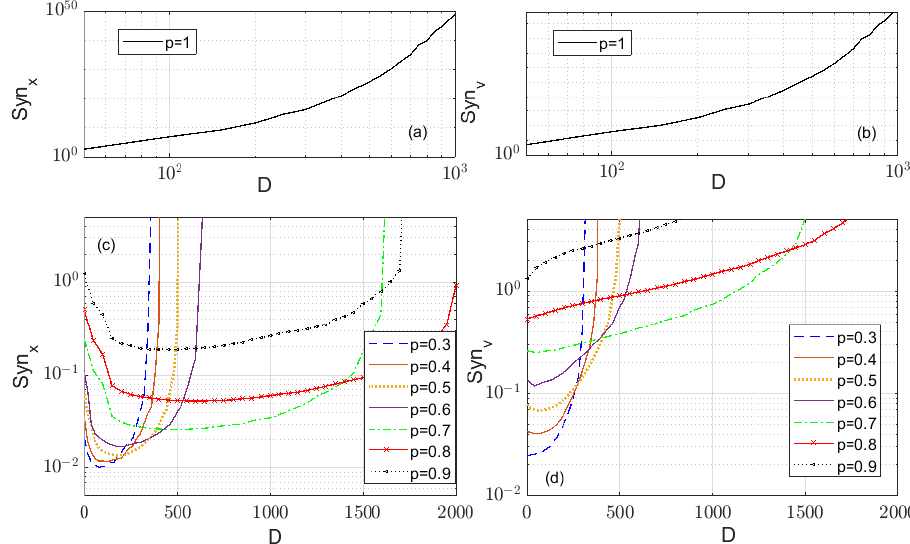
Figure 12. The average position synchronization error 𝑆𝑦𝑛 𝑥 ( a , c ) and average velocity synchroniza- tion error 𝑆𝑦𝑛 𝑣 ( b , d ) curves of noise intensity D with different fractional-orders 𝑝 (Gaussian noise controlled by cosine function).